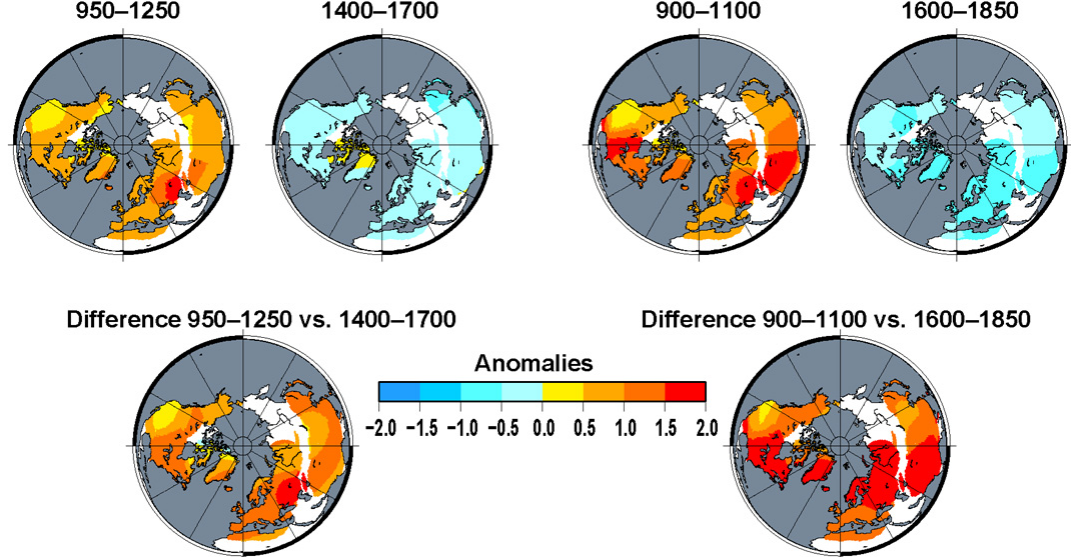
Fig. 6. The mean and differences in anomaly values from our spatial reconstruction using the same two MWP and LIA periods defined in Mann et al.